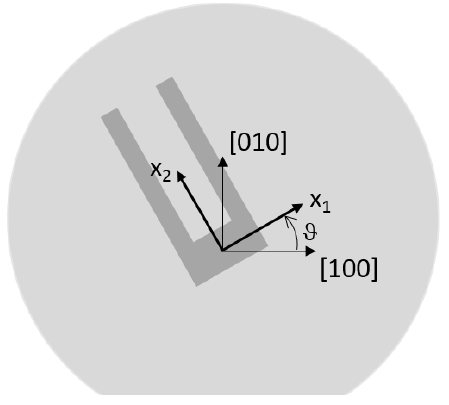
Table 1. Doping concentration dependence of the elastic constants of silicon and their temperature dependences. Elastic constants are expressed in GPa, while Tc ij